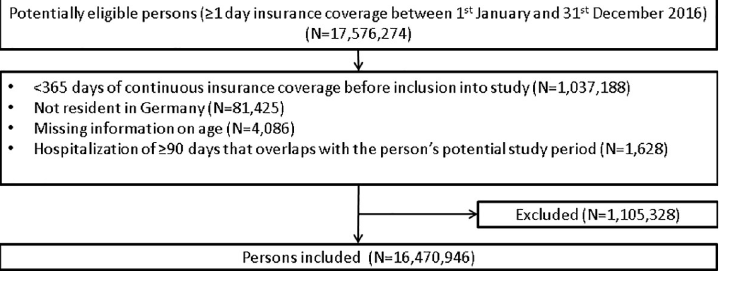
Fig 2. Flow chart illustrating the inclusion and exclusion of persons into the